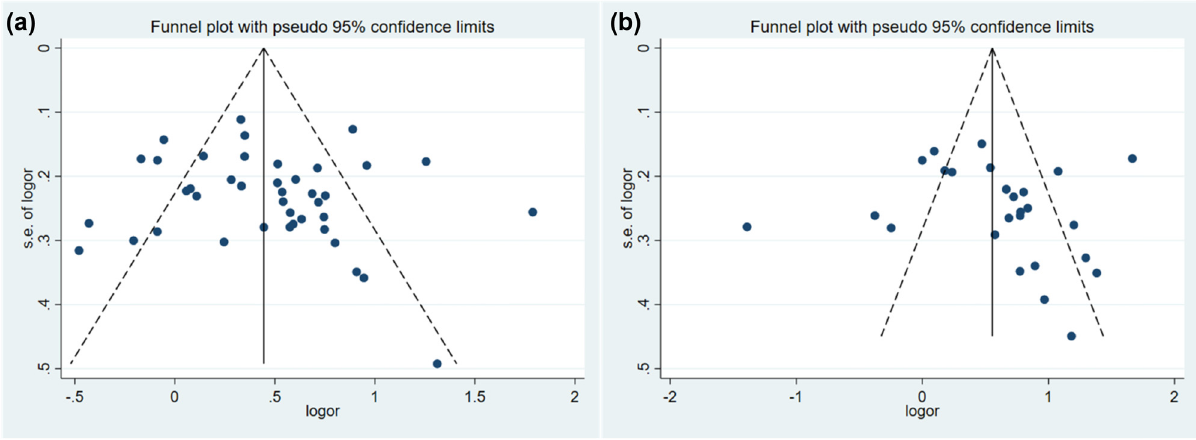
Figure 4: Funnel plot analysis to detect publication bias for MTHFR C677T polymorphism. ( a ) Comparison with DM controls and ( b ) comparison with healthy